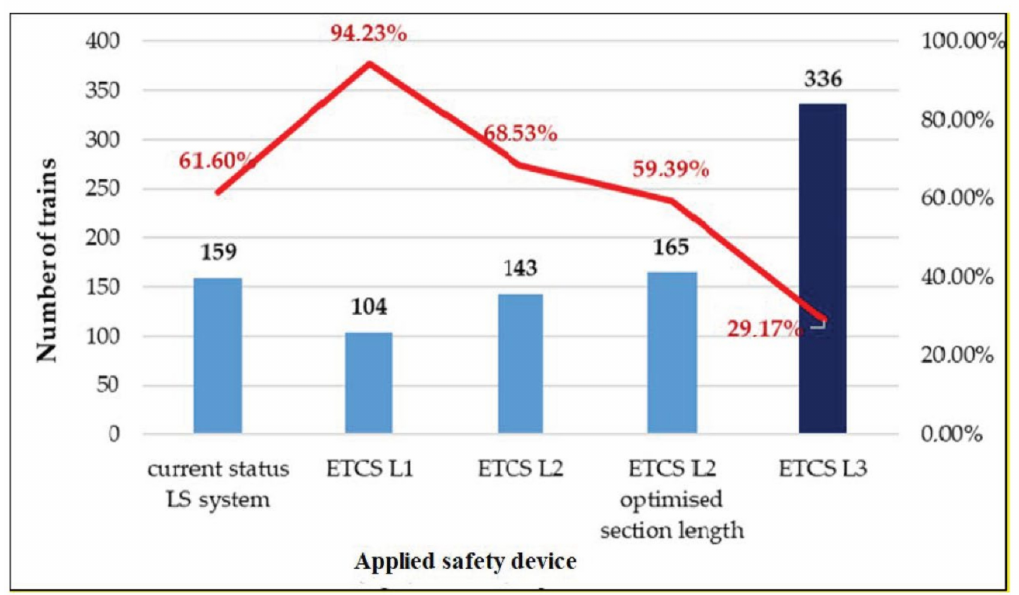
Figure 13. Mutual comparison of the resulting practical throughput (in number of trains per day) for individual